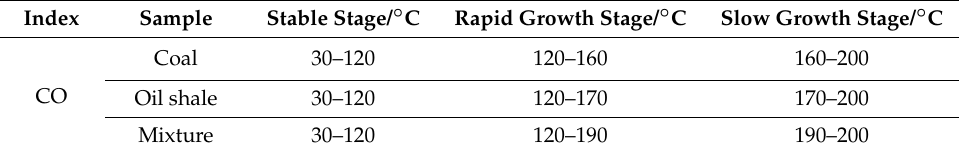
Table 3. Three sample stages with respect to CO concentration.